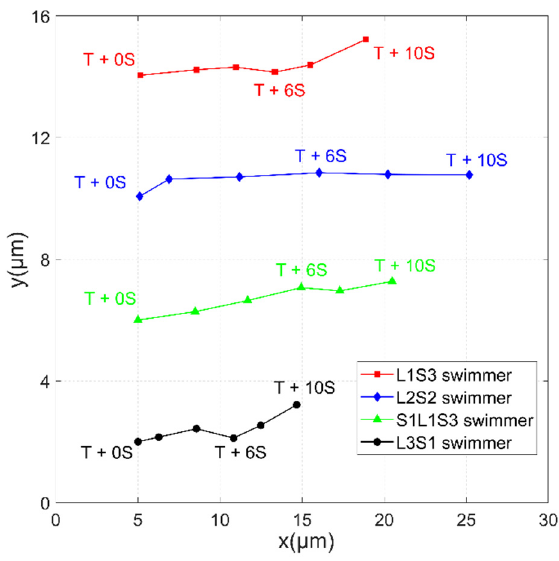
Figure 9. Trajectories of the swimmers in Figure 8 moving more 10 s.